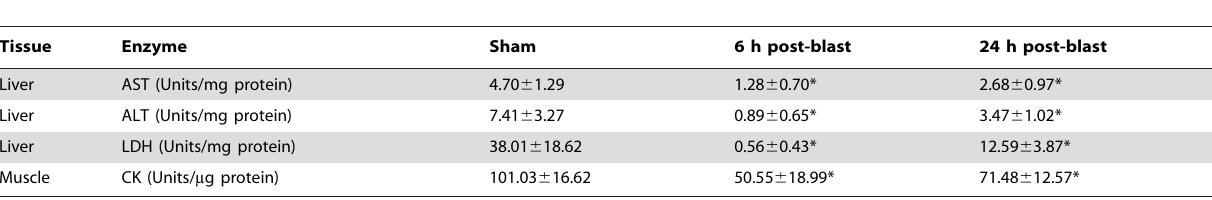
Table 2. Enzyme activities in the liver and muscle tissues at 6 and 24 h after repeated blast exposures.